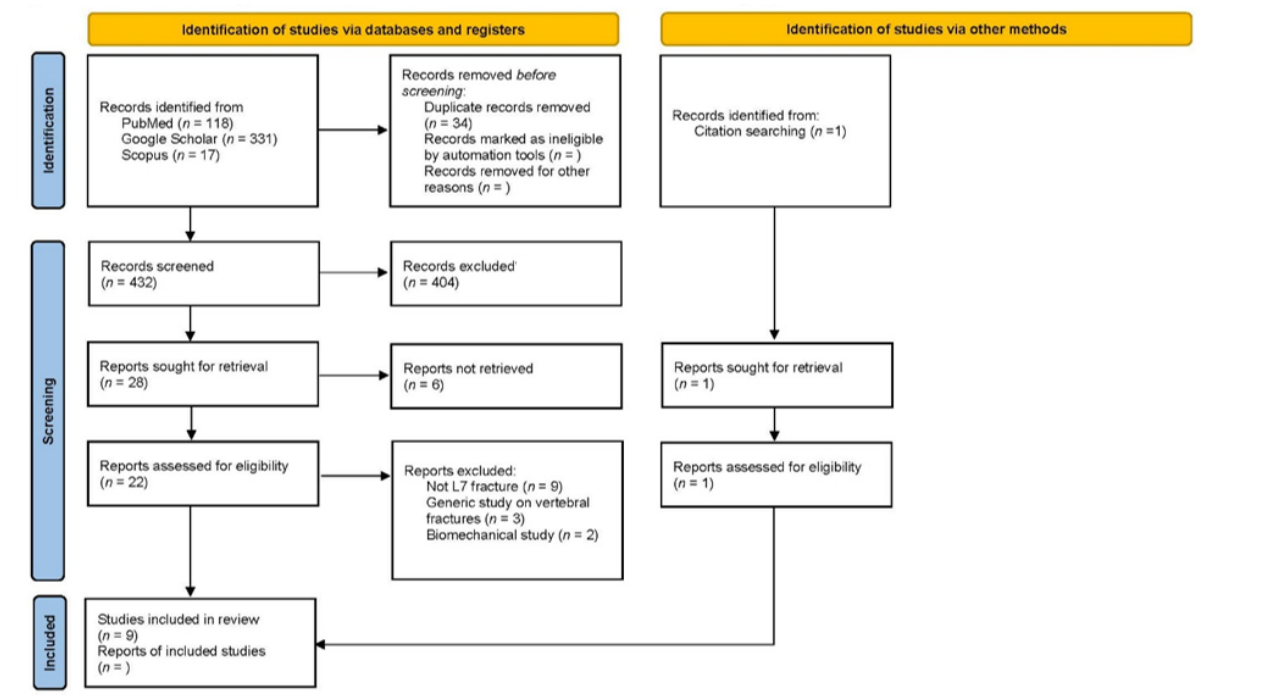
Figure 1. PRISMA 2020 flow diagram for new systematic reviews, which included searches of databases, registers and other